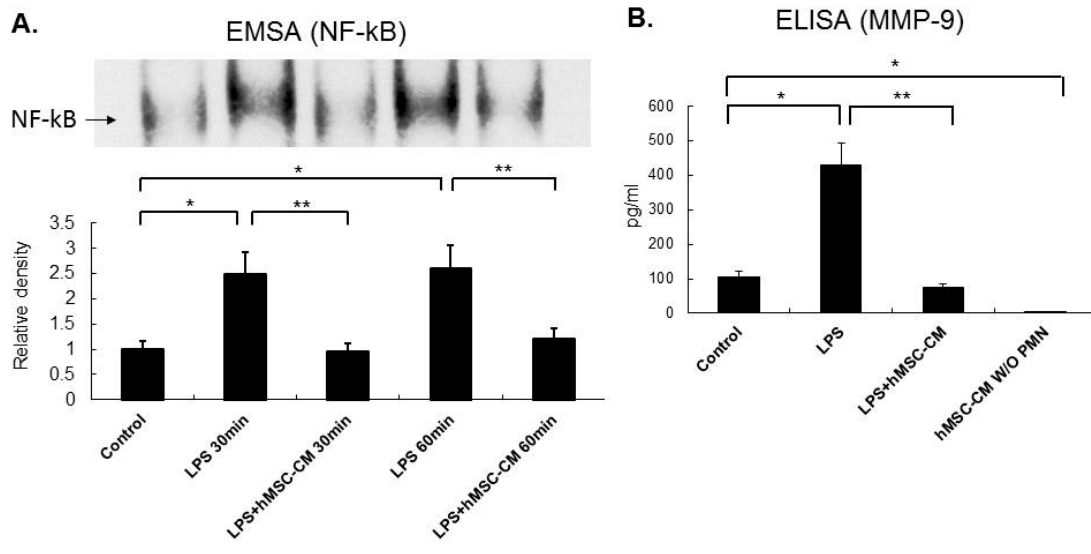
Figure 6. The human MSC-CM (hMSC-CM) reduced NF-kB activation and the expression of MMP-9 in human neutrophils isolated from patients with ARDS. ( A ) Human neutrophils that were treated with LPS for 30 min or 60 min in vitro exhibited a significant increase in NF-kB activity in EMSA analyses compared to the control neutrophils. In contrast, human neutrophils that underwent LPS treatment (30 min or 60 min) and hMSC-CM (LPS + hMSC-CM) showed a marked reduction in NF-kB activation compared to LPS-treated neutrophils. ( B ) In ELISA assays of MMP-9 activity from culture mediums of human neutrophils in vitro, greater activity was observed after LPS treatment, while a marked reduction in MMP-9 activity was observed after LPS + hMSC-CM treatment. Data are presented as the mean ± SD. * p < 0.05, compared to the controls; ** p < 0.05, compared to the LPS group; n = 6 per group.